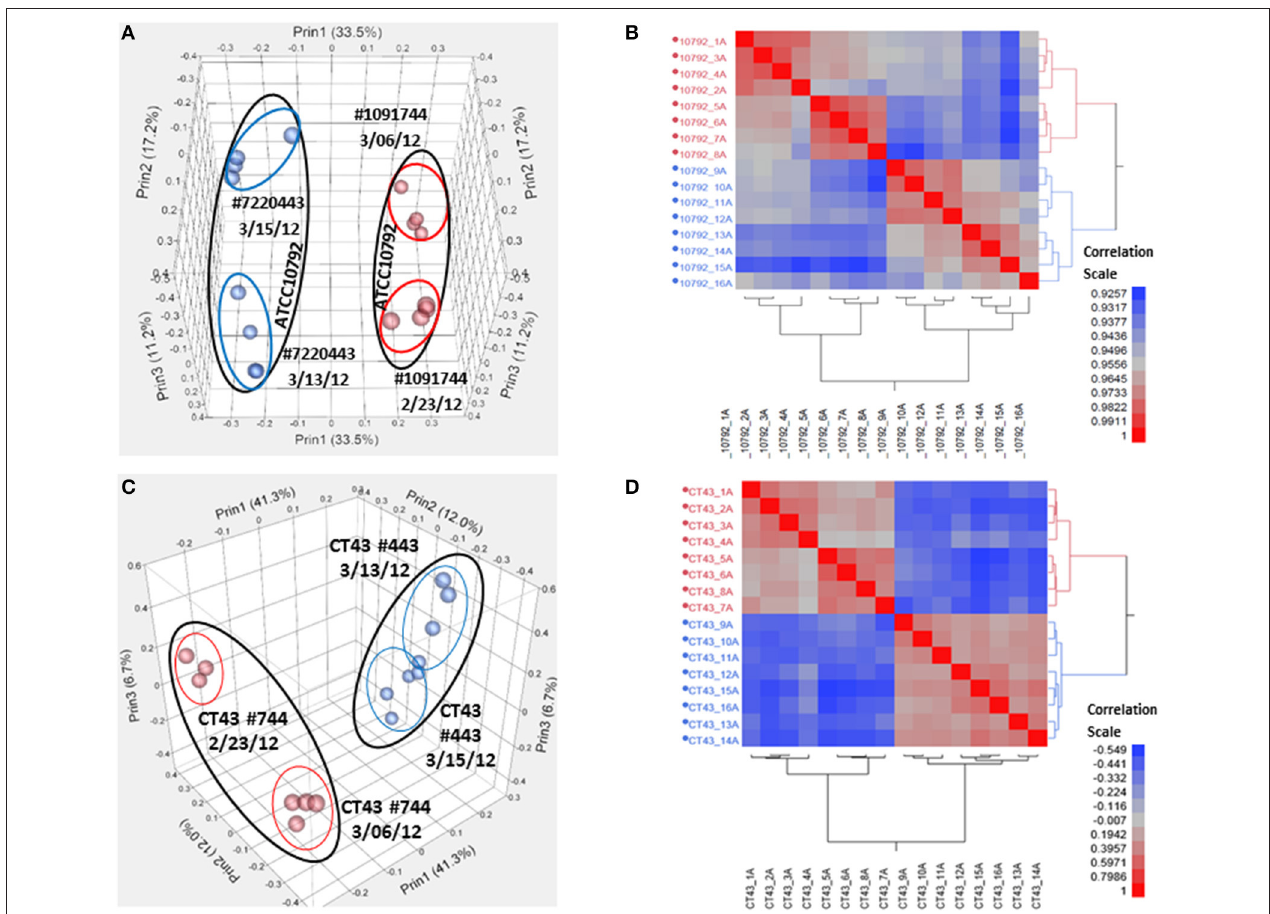
FIGURE 2 | Variation analysis of raw read count data for strain ATCC10792 and strain CT43. (A) Principal Component Analysis (PCA) for ATCC10792 using a Pearson correlation coefficient and colored by media, (B) Hierarchical cluster analysis of the same data for strain ATCC10792, (C) PCA for CT43 and (D) CT43 cluster